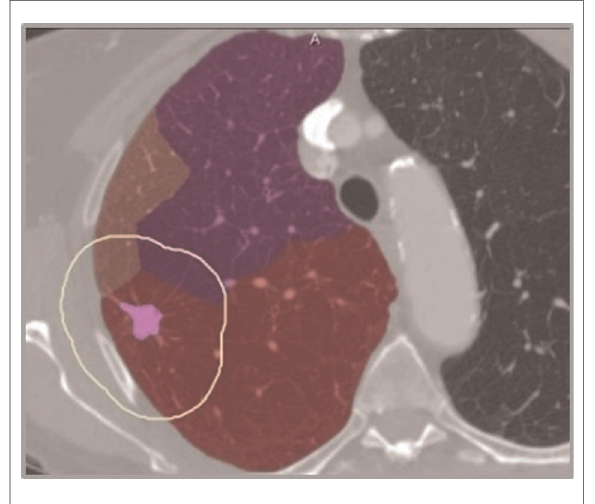
FIGURE 7 Distance between tumor and segment border (2 mm).